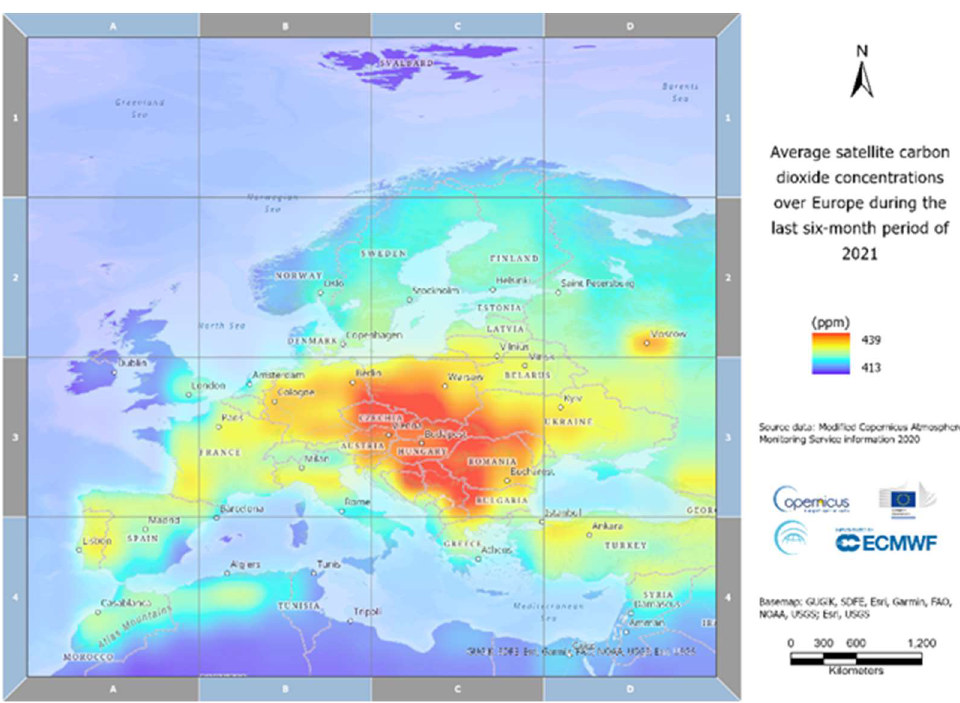
Figure 1. Visualization of the mean spatial distribution of carbon dioxide over Europe during the last period of 2021. Red and blue colors represent the highest and the lowest average values of CO 2 . Data were retrieved and modified from Copernicus Atmosphere Monitoring Service (CAMS).